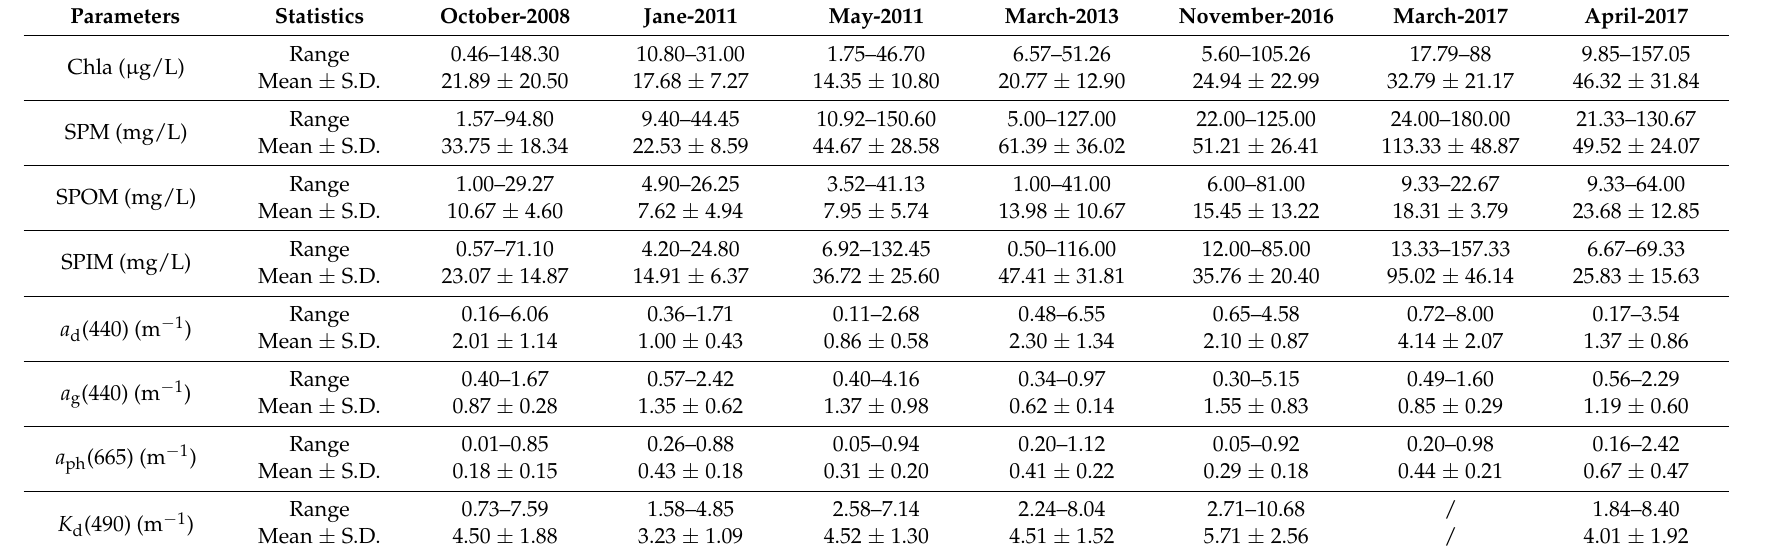
Table 1. Water parameters and optical properties of Lake Taihu, China. Chla, SPM, SPOM, and SPIM are chlorophyll a, suspended particle matter, suspended particulate organic matter, and suspended particulate inorganic matter, respectively. SDD is the Secchi disk depth, and a d (440), a g (440), and a ph (665) are the absorption coefficients of non-algal particulates, colored dissolved organic matter (CDOM), and phytoplankton, respectively. K d (490) is the downwelling diffuse attenuation coefficient at 490 nm. S.D. is the standard